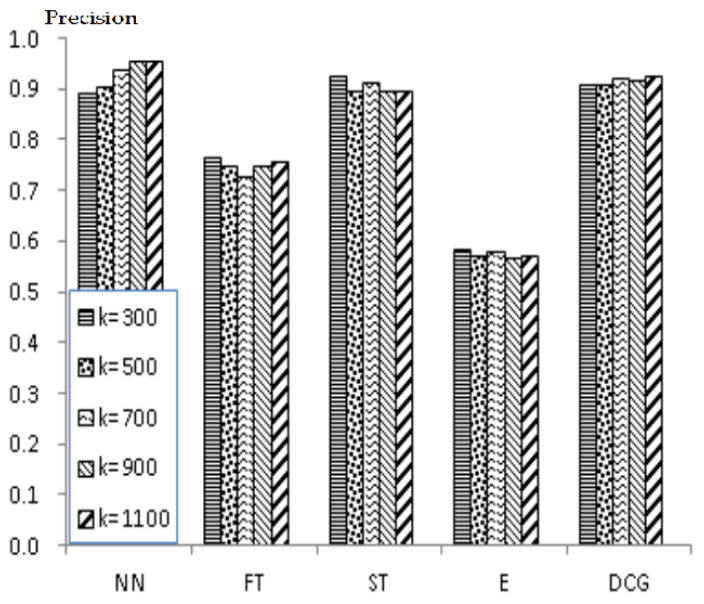
Figure 5. The five evaluation criteria of each codebook size 𝑘 .